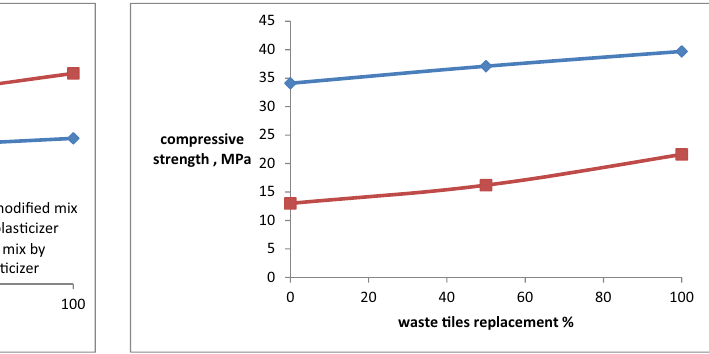
Figure 13: Compressive strength development due to waste tiles replacement ( comparison with previous study given in ref. [ 5 ]) .